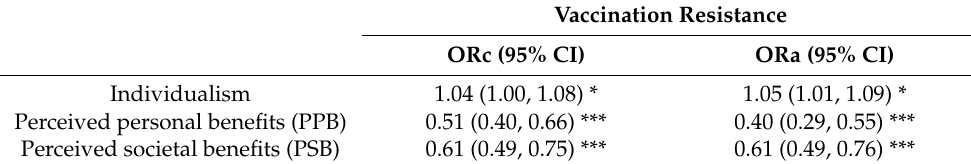
Table 2. Factors of vaccination resistance (n = 395)